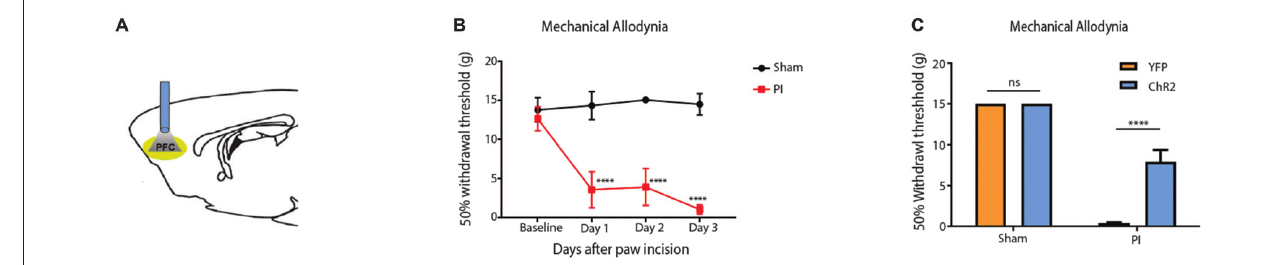
FIGURE 3 | Activation of the PFC relieves acute incisional pain. (A) Schematic showing fiber placement and optogenetic activation of PL-PFC neurons during mechanical allodynia tests. (B) Paw incision caused mechanical allodynia, compared with sham procedure involving only anesthesia treatment without incision. n = 6, p < 0.0001. A two-way ANOVA with repeated measures and post hoc multiple pair-wise comparison Bonferroni test was used to compare the 50% withdrawal threshold for paw incisional (PI)- treated and control rats. (C) Light activation of ChR2-expressing neurons in the PL-PFC decreased mechanical allodynia in PI-, but not sham-treated rats. Light treatment did not have any effect on animals which received vectors containing YFP-only. Two-way ANOVA with Bonferroni post-test, n = 7–8, p < 0.0001. Light treatment was performed at least 2 weeks after PI/sham procedures. Error bars show mean and SEM.